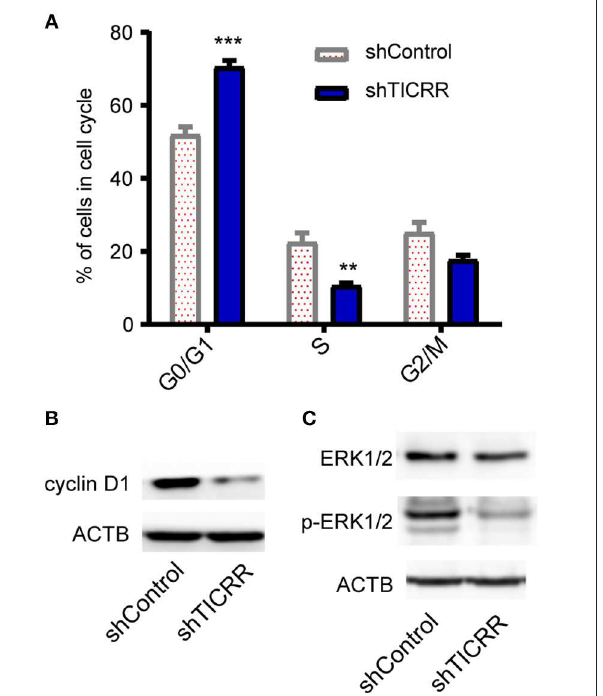
FIGURE 5 | Knockdown of TICRR inhibited cell cycle. (A) Cell cycle analysis was performed by PI-DNA staining in TICRR -knockdown cells compared with control in MCF7 cells. ** p -value < 0.01, *** p -value < 1.0 × 10 − 3 , two-way ANOVA test. Results were displayed as means ± SEM, N = 3 biological replicates. (B) cyclin D1 protein level were shown in MCF7 cells. (C) ERK1/2 and p-ERK1/2 protein levels were shown in MCF7. N = 3 biological